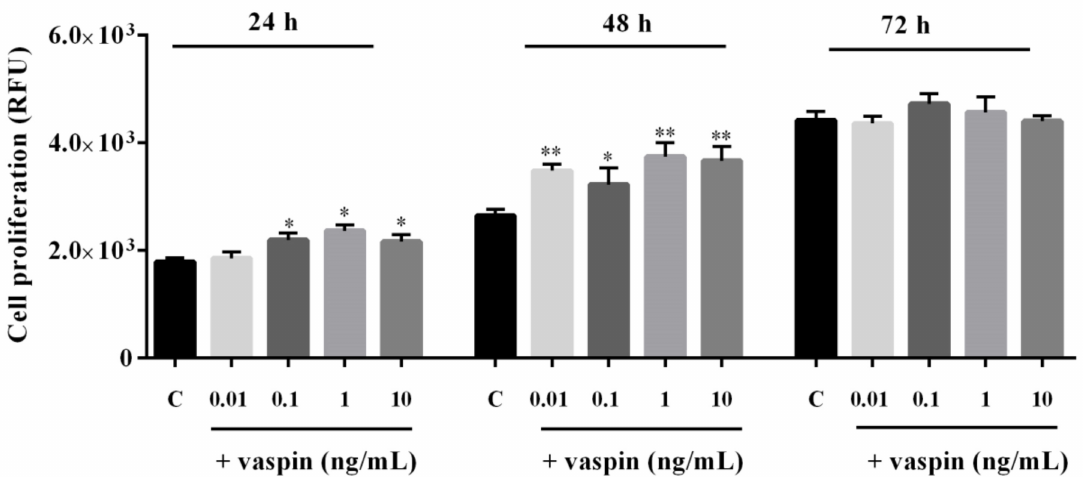
Figure 1. Dose- and time-dependent e ff ect of vaspin on granulosa (Gc) proliferation: Gc were seeded in 96-well culture plates in M199 medium at a concentration of 5 × 10 4 viable cells per well. The